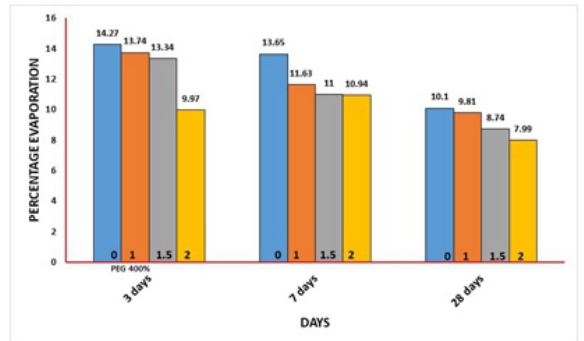
Fig. 2. Percentage Evaporation Values at 0.34 Water-Cement Ratio.